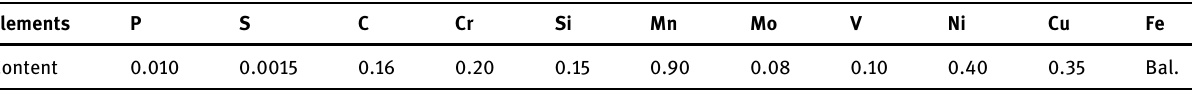
Table 1: Chemical compositions of the high strength hull steel EH40 ( wt% ) Elements